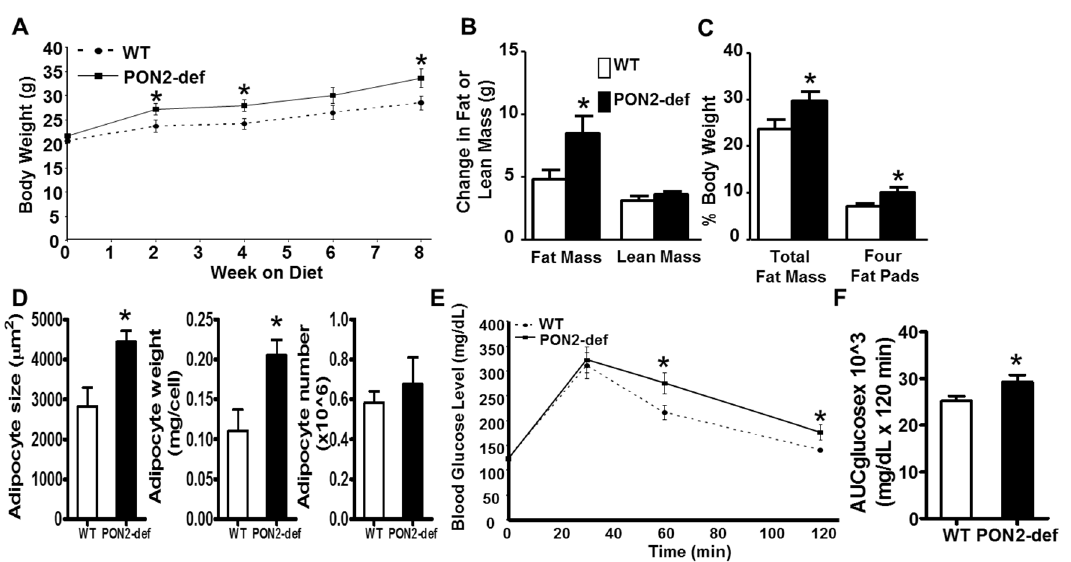
Figure 1. PON2-deficient (PON2-def) mice are more prone to diet-induced obesity and exhibit glucose intolerance. (A) to (D) Two-month-old female PON2-def and wild-type (WT) mice ( n = 10 for each group) were fed an obesifying diet for 8 weeks before sacrifice. ( A ) Body weights of mice at baseline (week 0), 2, 4, 6, and 8 weeks after the start of obesifying diet feeding are shown. ( B ) Changes in Fat or lean mass after 8 week-feeding of the obesifying diet are shown. ( C ) Total fat mass and weight of four fat pads (gonadal, mesenteric, retroperitoneal, and subcutaneous fat pads), expressed as % of body weight, at sacrifice are shown. ( D ) The mean adipocyte size, weight, and number of subcutaneous fat pads are shown. ( E ) Glucose tolerance test data of WT and PON2-def mice fed the obesifying diet for 7 weeks are shown. ( F ) Mean AUC data of IPGTT are shown. *: p < 0.05 vs. WT group. Table 1. Plasma lipid, glucose, and insulin levels of WT and PON2-def mice fed the obesifying diet for 8 weeks.